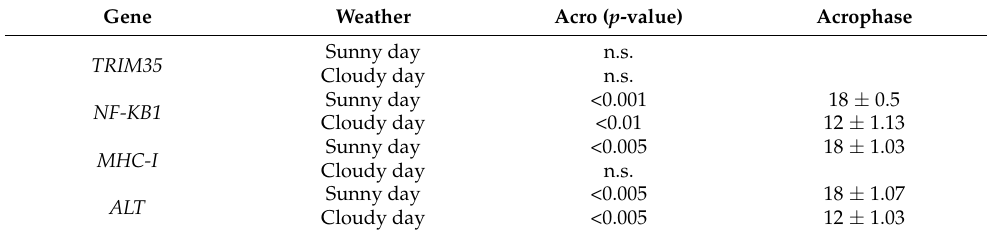
Table 7. Cosinor analysis board for immune genes expression under sunny and cloudy